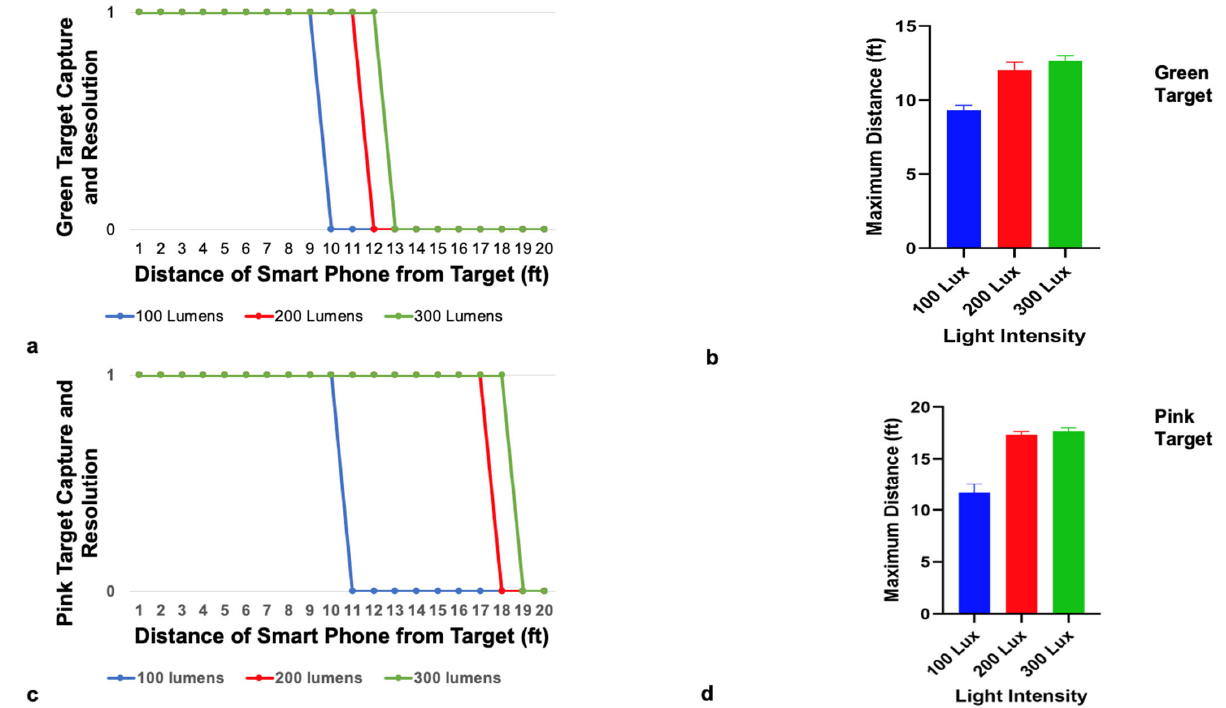
Figure 10. ( a ) Target capture and resolution comparison with neon green target in various luminos ‐ ities. ( b ) Effect of light intensity on maximum distance capture and resolution with a green target. ( c ) Target capture and resolution comparison with neon pink target in various luminosities. ( d ) Effect of light intensity on maximum distance capture and resolution with a pink target in various luminosities.